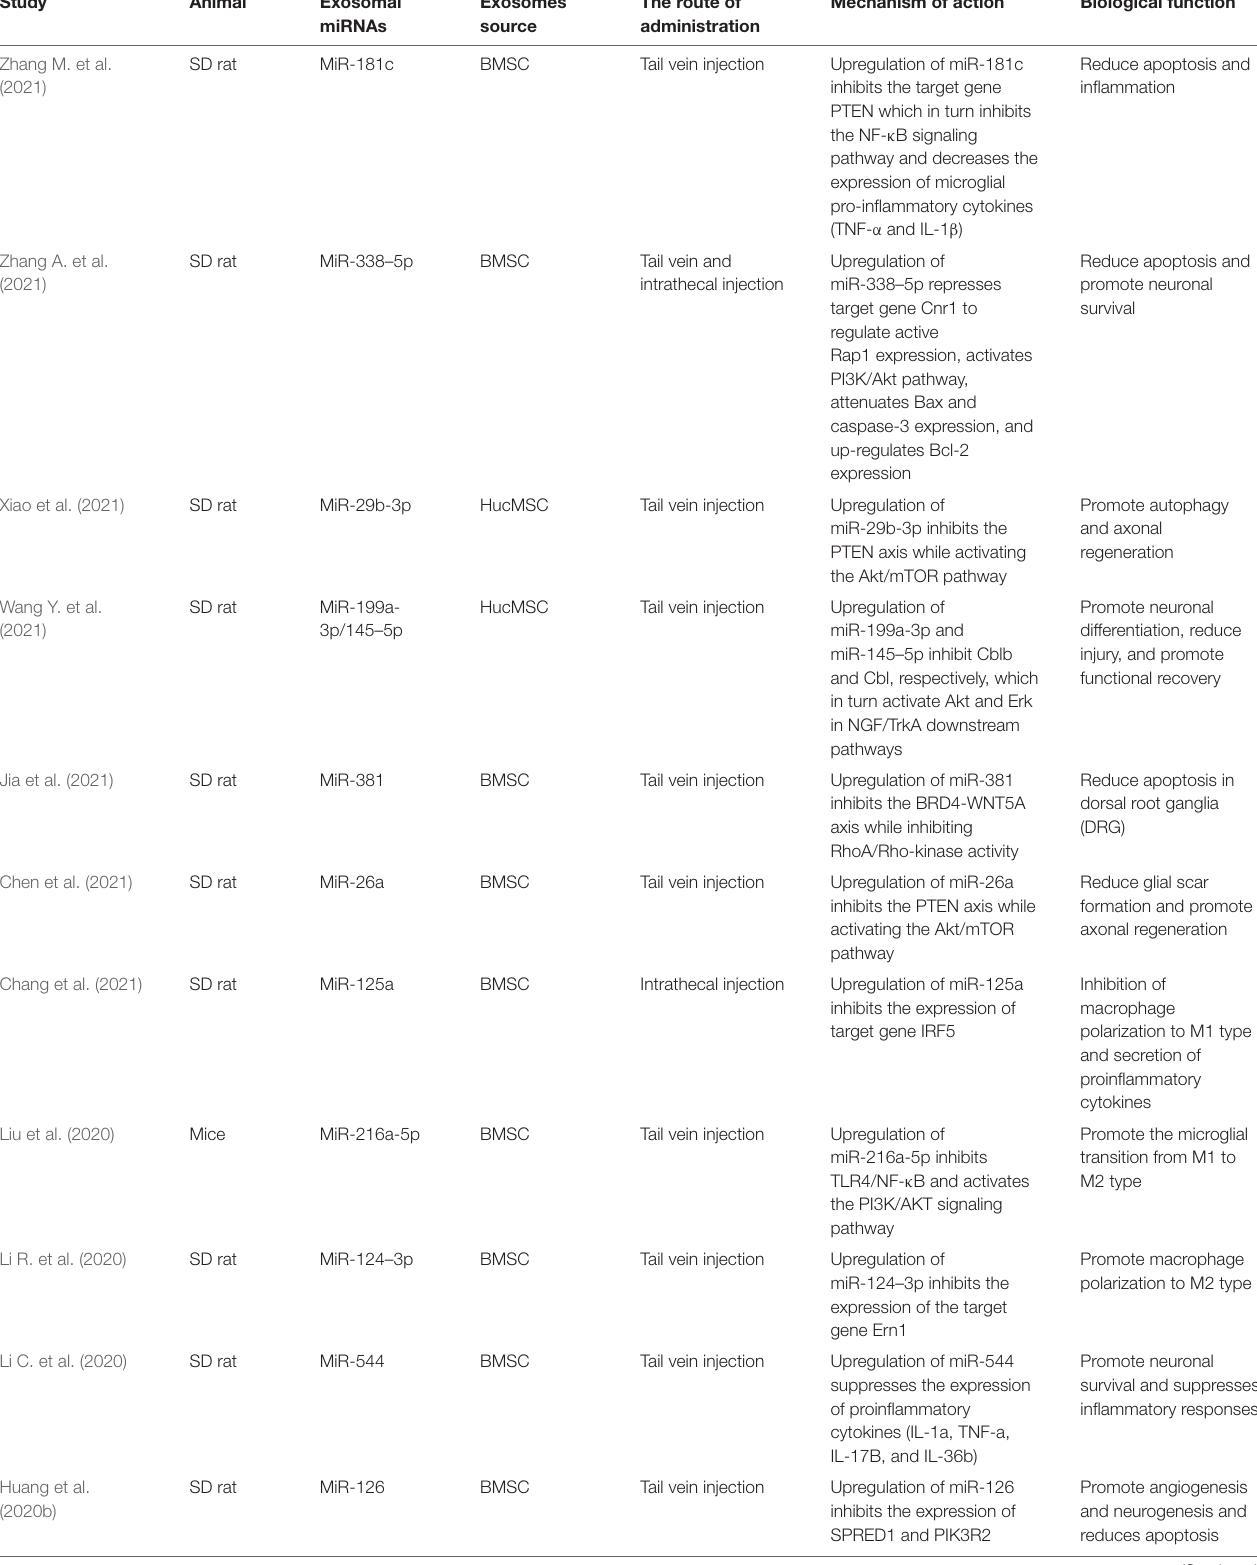
TABLE 1 | Studies about MSC-derived exosomes and exosomal miRNAs in the treatment of